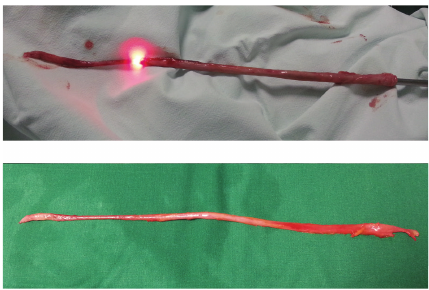
Figure 2: Two-point or “scabbard”